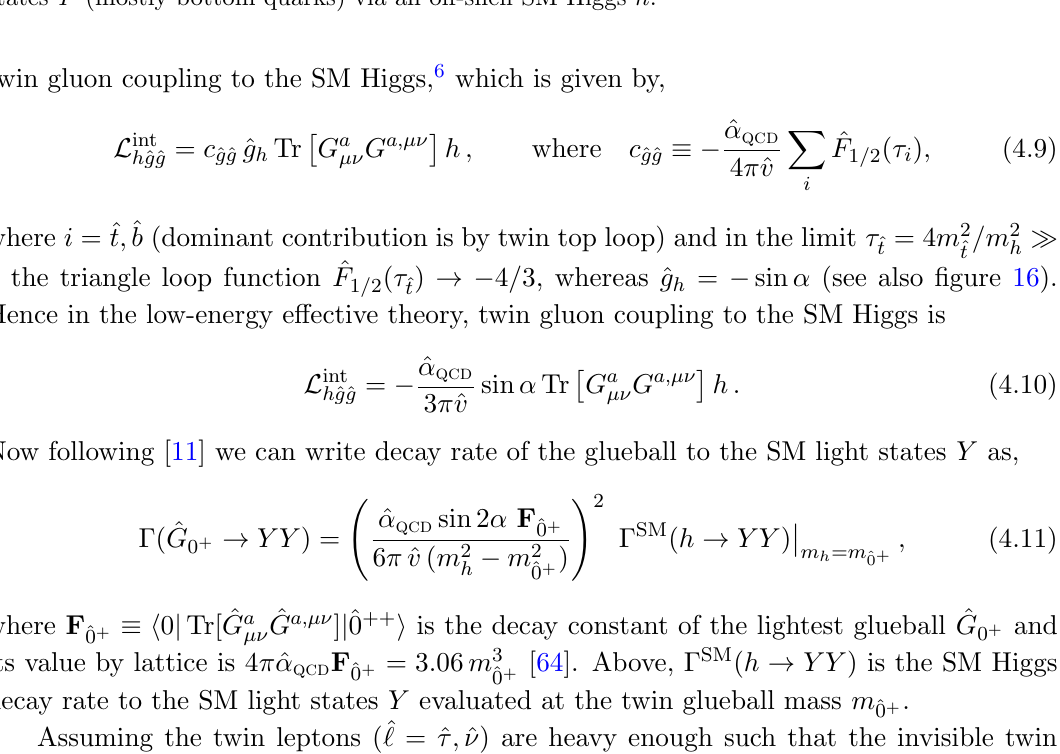
Figure 11 . Schematic diagrams of twin glueball ^ G states Y (mostly bottom quarks) via an o(cid:11)-shell SM Higgs h